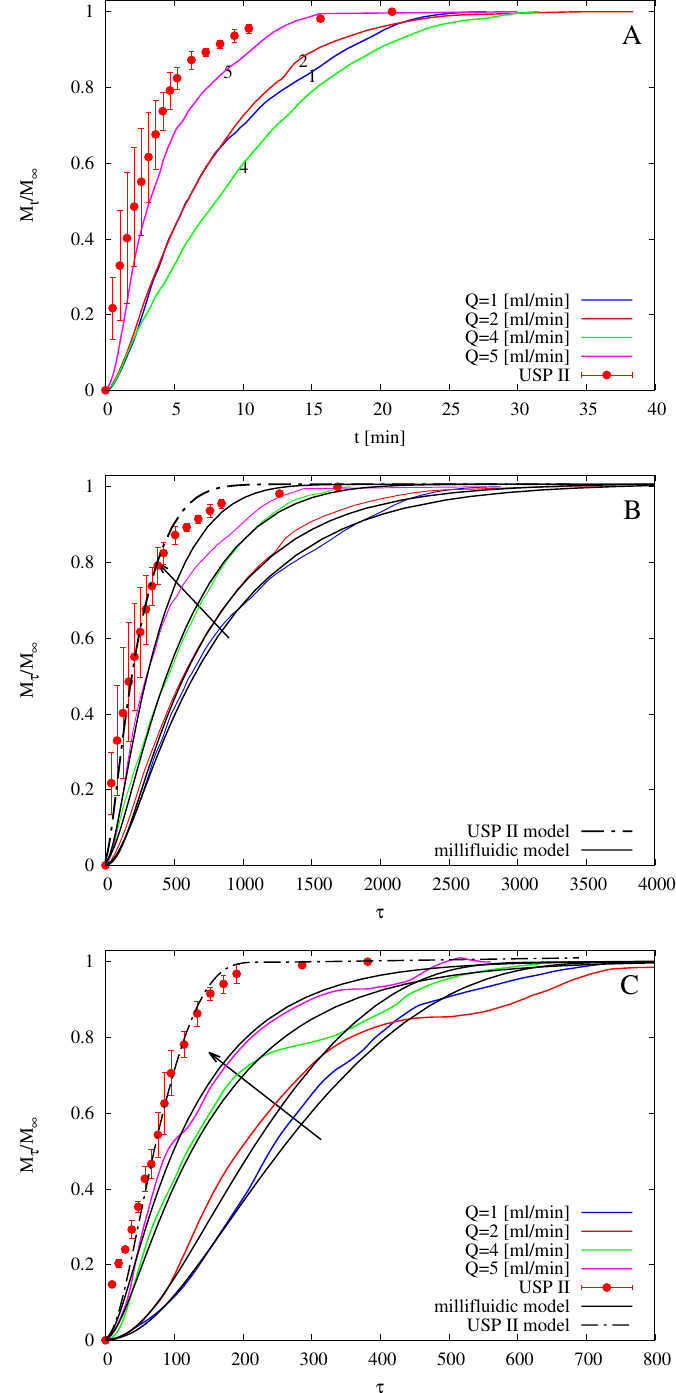
Figure 10. Drug releases at 37 ◦ C from USP II apparatus (paddle, 50 rpm) and from MFTD for different flow rates Q = 1,2, 4,5 mL/min. ( A ) M t vs. t , films without HP- β -CD. ( B ) M τ vs. τ = tD s without HP- β -CD. ( C ) M τ vs. τ , films with HP- β -CD. Arrows indicate increasing values of Q